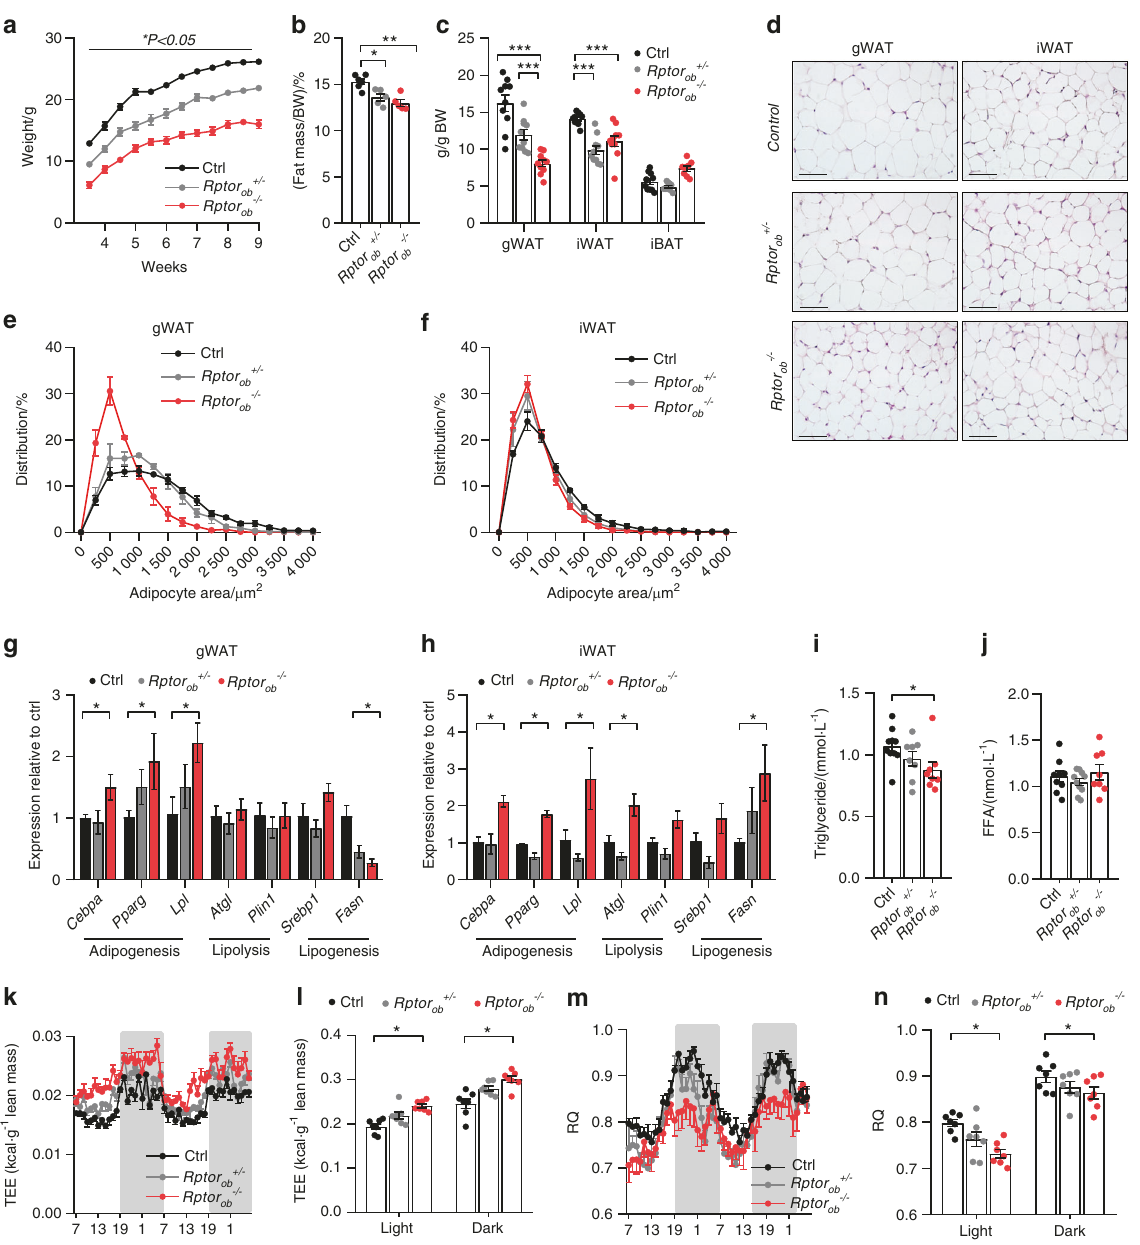
Fig. 1 Loss of mTORC1 function in pre-OBs results in a lean phenotype. a Temporal change in body weight ( n ≥ 15/genotype). b %Fat normalized to total body weight. c Body weight-adjusted gonadal and inguinal white adipose tissue (gWAT and iWAT) and interscapular brown adipose tissue (iBAT) mass (9 weeks of age; n = 10/group). d Representative H&E section of gWAT and iWAT, scale bar = 100 µm. e , f Size distribution of gWAT and iWAT adipocytes calculated from H&E stained sections using Image J ( n = 5 sections/mouse, n = 3 – 6/genotype). g , h Gene expression levels of adipogenesis, lipogenesis, and lipolysis genes, normalized to Actb , in gWAT and iWAT ( n = 3 – 5/genotype). i Serum triglyceride levels ( n = 8 – 10/genotype). j Serum-free fatty acid levels ( n = 8 – 10/genotype). k Total energy expenditure, normalized to lean mass, over 48 h and l per light/dark cycle. m Average respiratory quotient (RQ) over 48 h and n per light/dark cycle. Data are expressed as mean ± SEM from n = 7/group, unless indicated otherwise. * P < 0.05, ** P < 0.01, *** P < 0.001, one-way ANOVA with Tukey ’ s post hoc test. k , m Shaded regions represent dark have shown that the skeleton can regulate appetite and glucose The metabolic improvements observed in Rptor ob − / − mice occur homeostasis via lipocalin-2 (LCN2), 20 an OB-enriched, secreted protein. independently of osteocalcin As shown in Fig. 3a – c, OCN gene ( Bglap ) expression and circulating To determine if increased LCN2 levels may be compensating for the levels of total and unOCN were signi fi cantly reduced in Rptor ob + / − decreased unOCN levels observed in Rptor ob + / − and Rptor ob − / − mice, serum LCN2 levels were measured; however, no differences were and Rptor ob − / − mice compared to controls (consistent with the found across the three genotypes (Fig. 3d). previously reported osteopenia observed in these mice 14 ), suggesting In contrast, the increase in insulin sensitivity in Rptor ob − / − mice that OCN is unlikely to be mediating the metabolic improvements observed in Rptor ob − / − mice. In addition to OCN, more recent studies was associated with a signi fi cant (Approximately twofold)